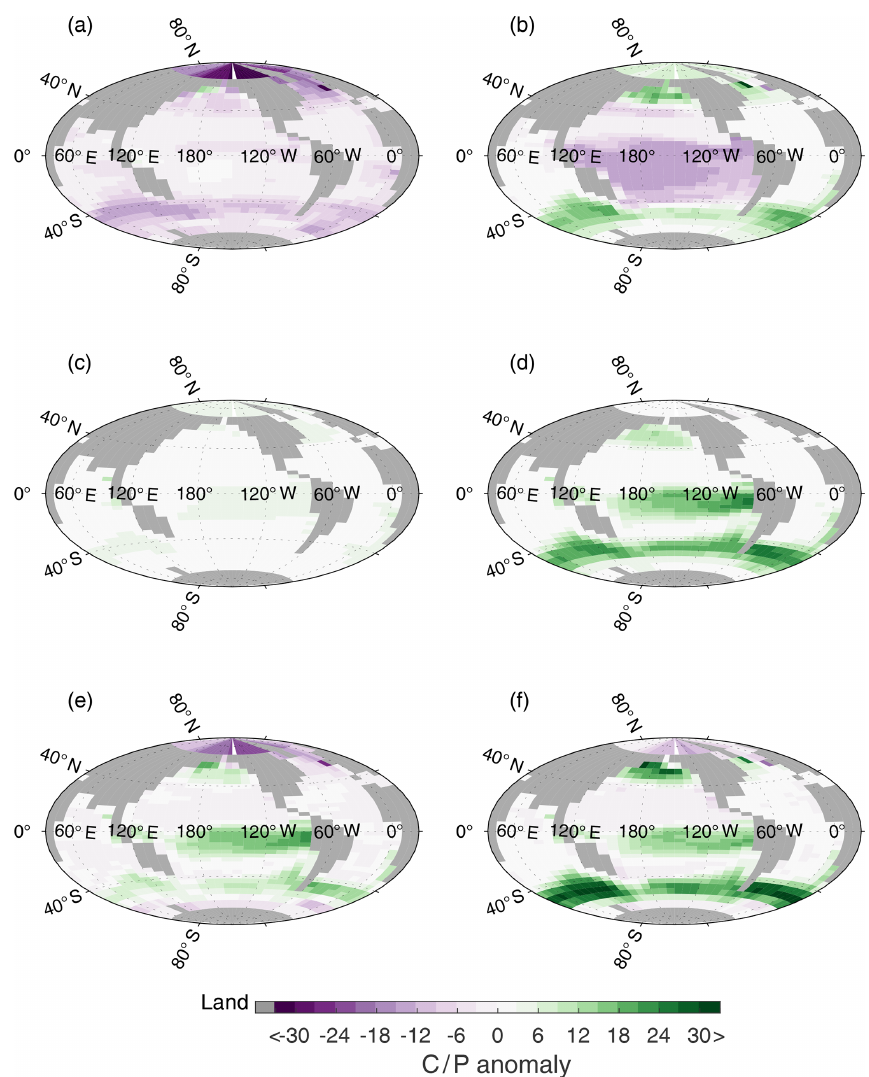
Figure 8. Surface C / P anomaly, with respect to C / P of Ctrl GAM (Fig. 3b), for (a) LGMphy GAM , (b) WSN × 0 . 5 GAM (c) RLS × 1 . 25 GAM , (d) LGMdust GAM , (e) Acomb GAM , and (f) GLcomb GAM